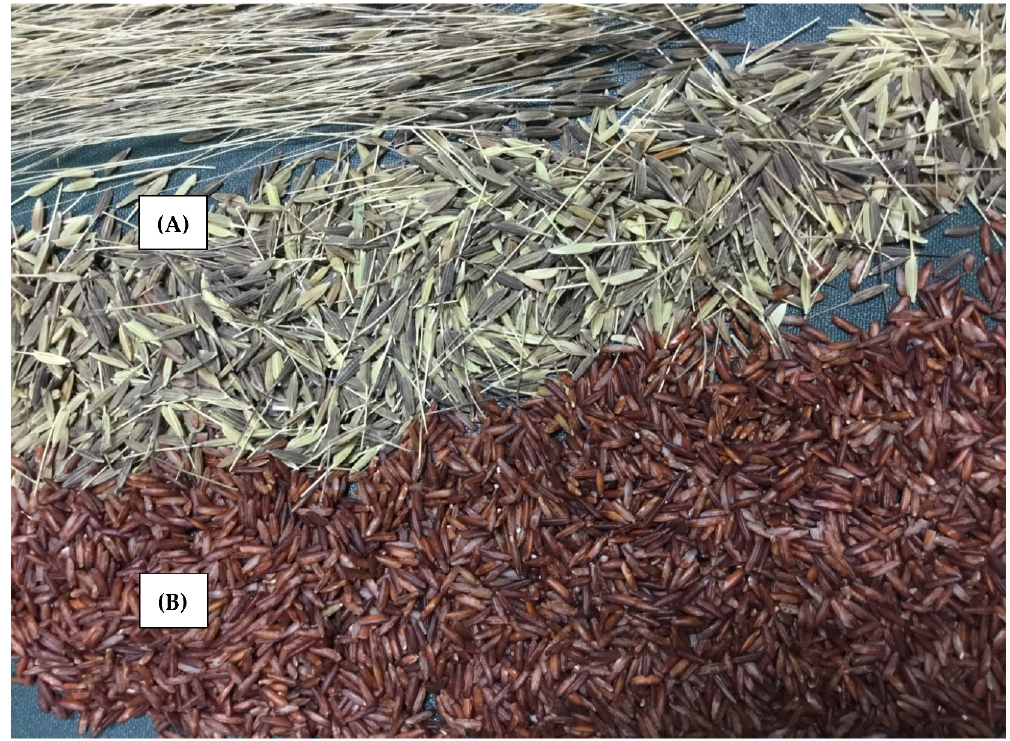
Figure 4. Australian wild Oryza meridionalis grains. ( A ) Grains with awns; ( B ) Processed grains without awns.